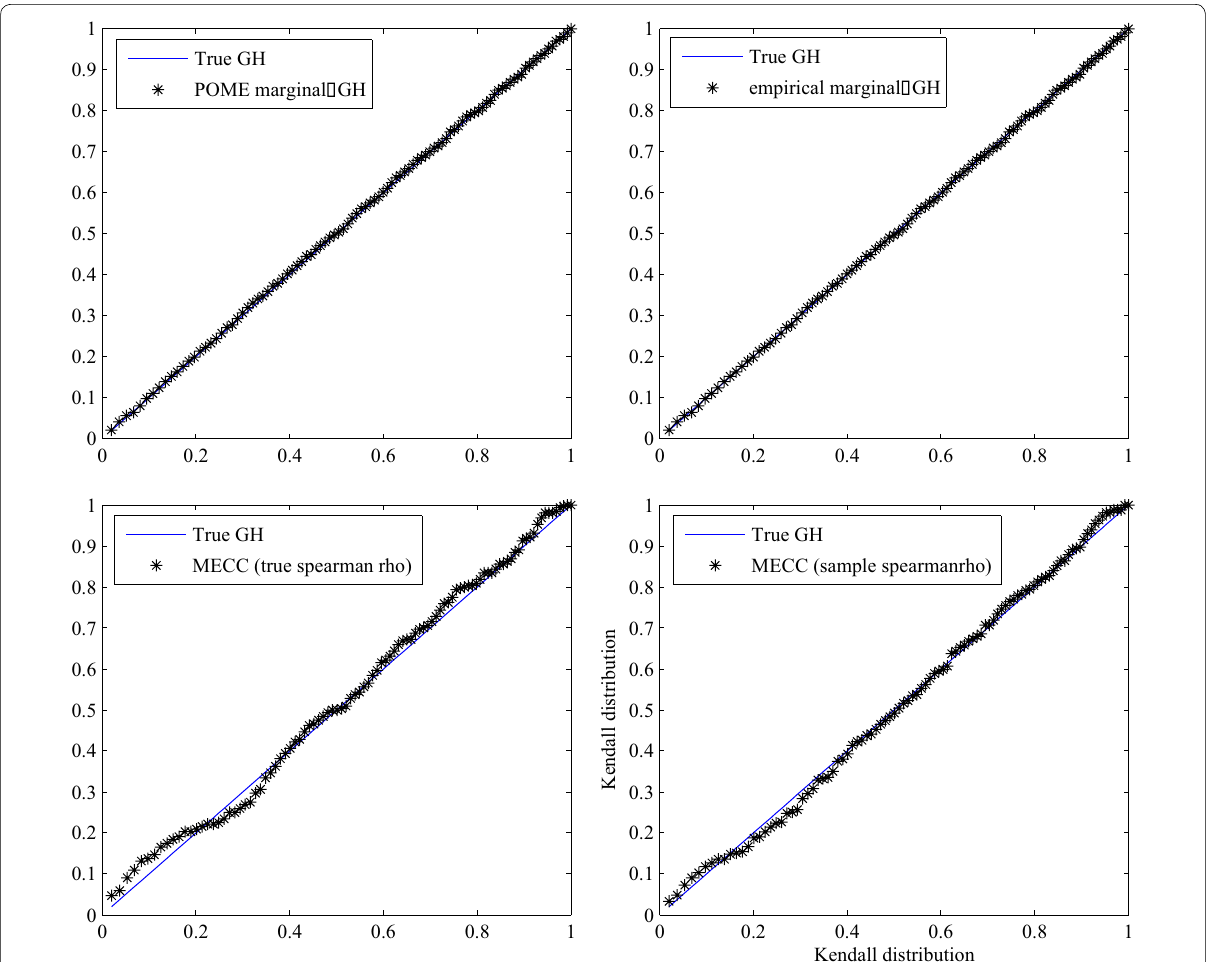
Fig. 3 Comparison of Kendall distribution from fitted Gumbel–Hougaard copula and MECC to that of the true Gumbel–Hougaard